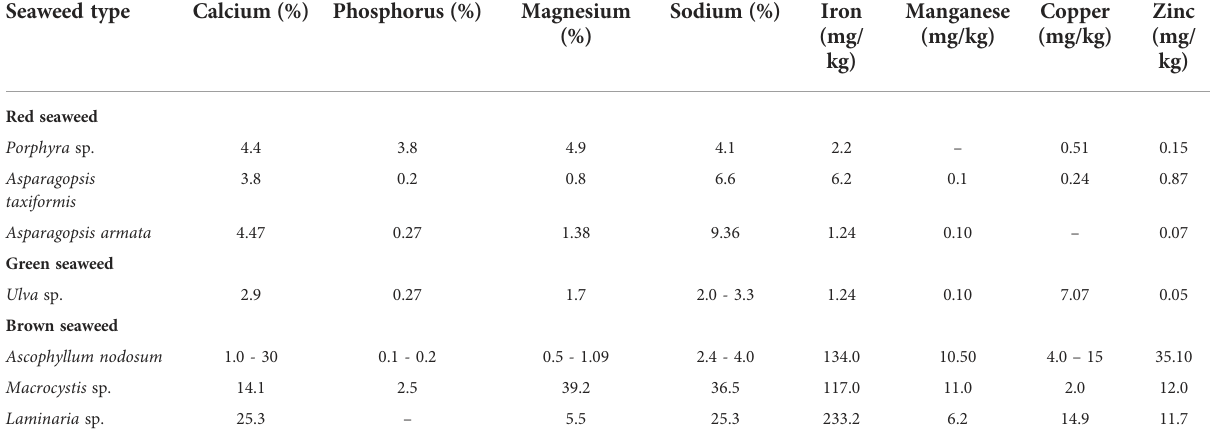
TABLE 2 Species-induced variation in mineral composition of seaweeds 1 . Seaweed